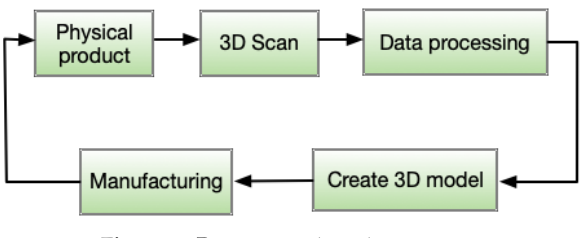
Figure 1. Reverse engineering process.